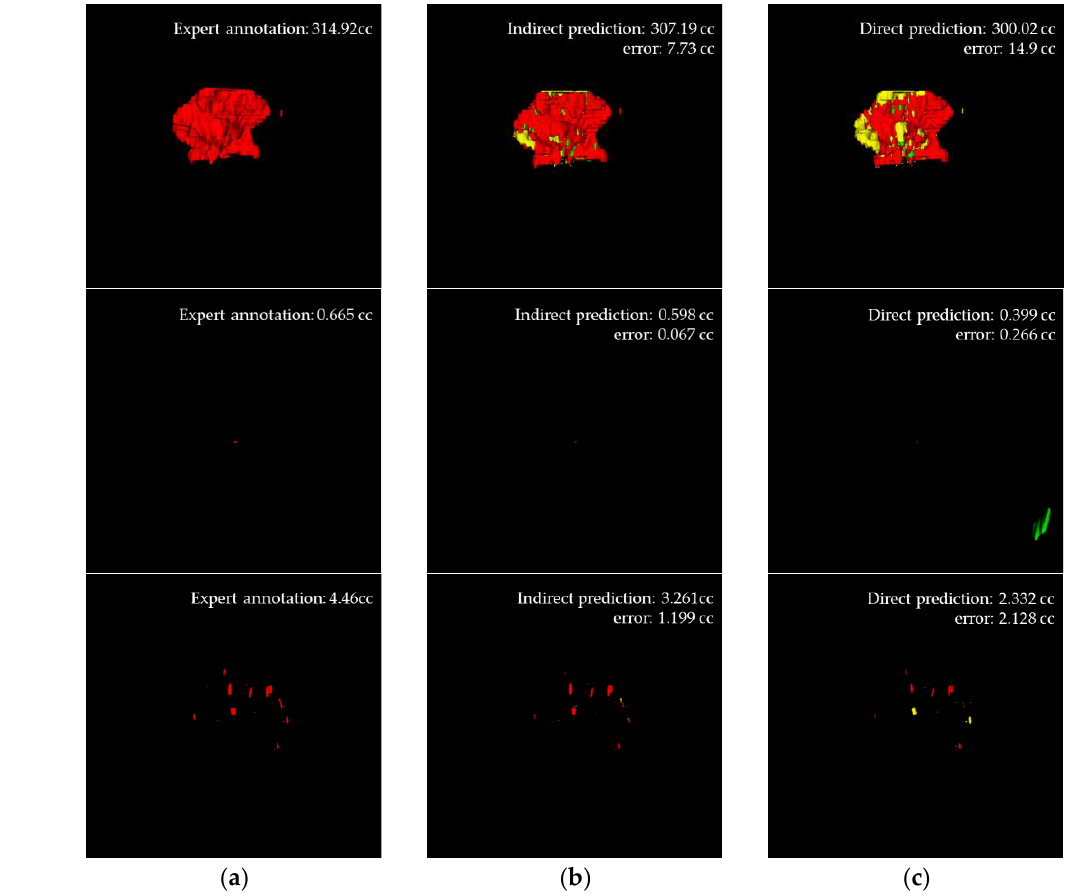
Figure 6. Visual results for ( A ) large AIS, ( B ) small AIS and ( C ) sparsely located small AIS ( TP is red, FP is green and FN is yellow): ( a ) Expert annotation, ( b ) Predicted indirect volume, and ( c ) Predicted direct volume.